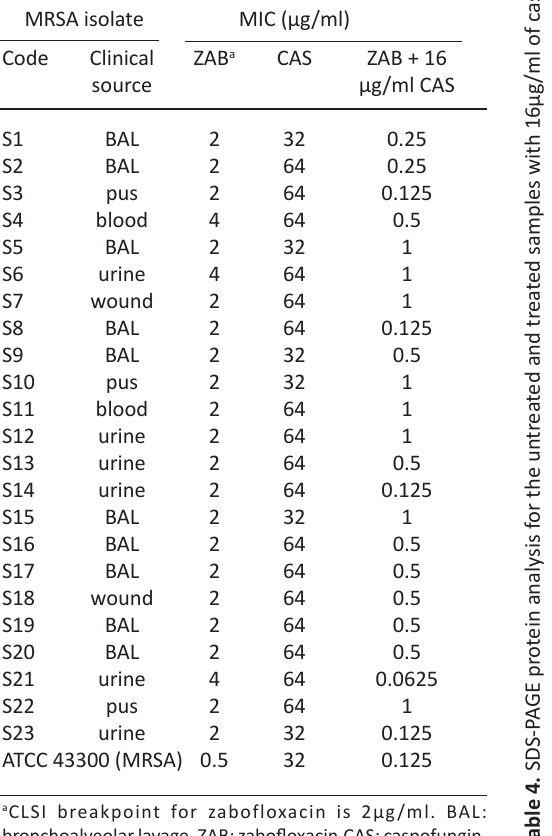
Table 3. In vitro activity of zabofloxacin alone and combined with caspofungin (16µg/ml) against 23 MRSA clinical strains isolated from different